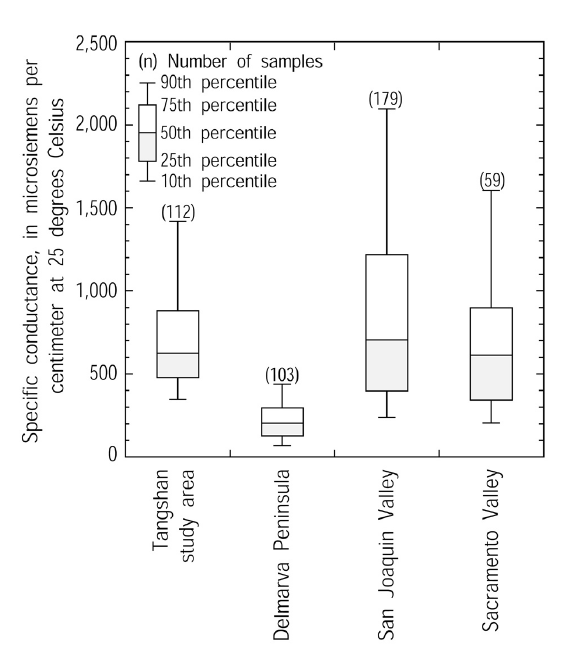
FIGURE 5. Boxplots of specific conductance for wells within each study area.